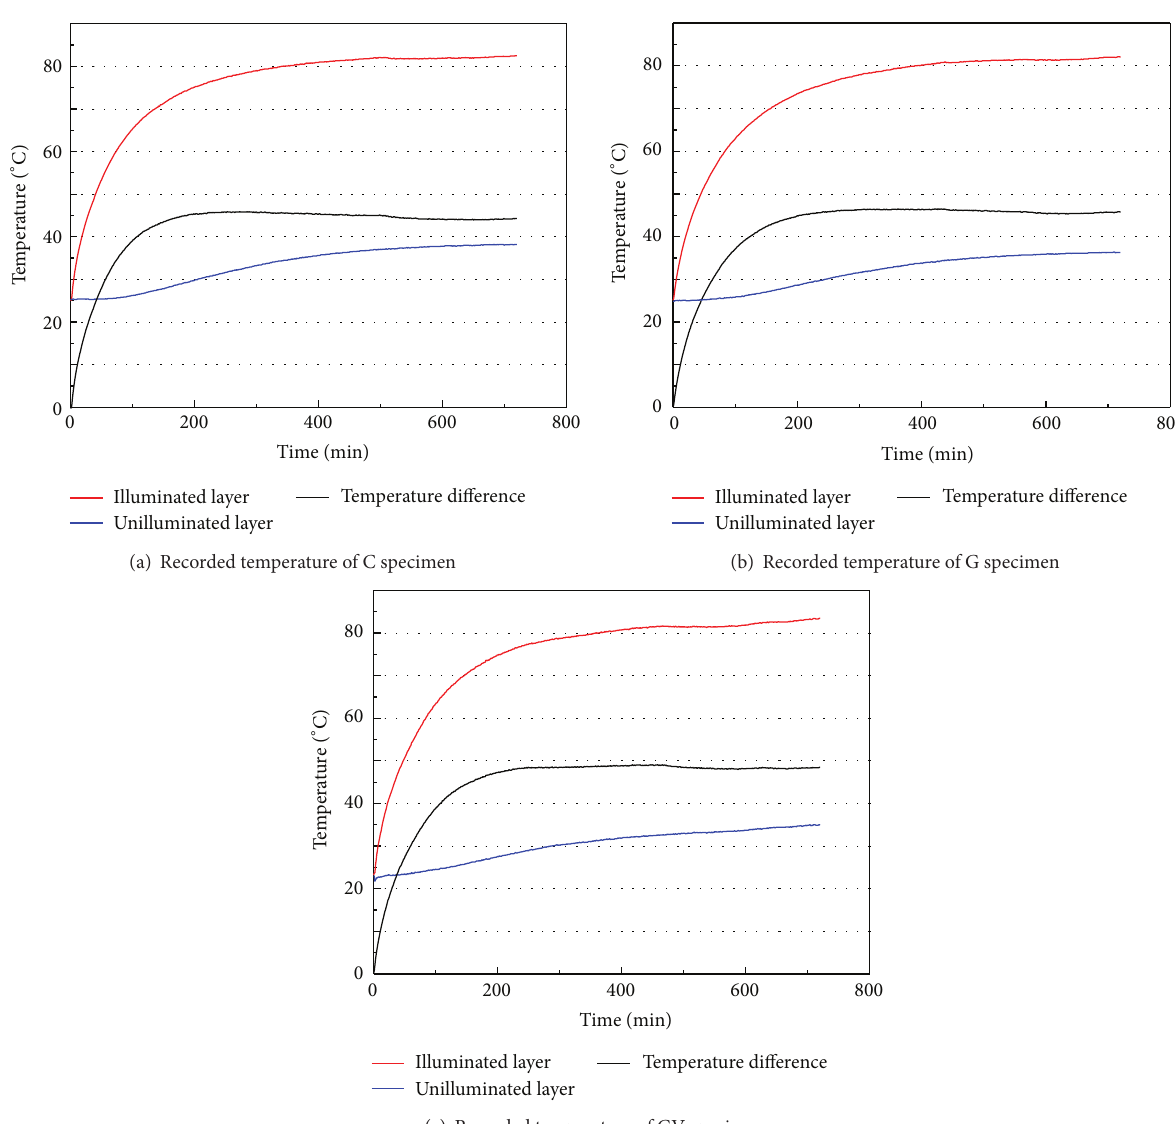
Figure 5: Experimental results showing the temperature variation against time ( 𝑇 - 𝑡 curve) in the (a) C specimen, (b) G specimen, and (c) GV